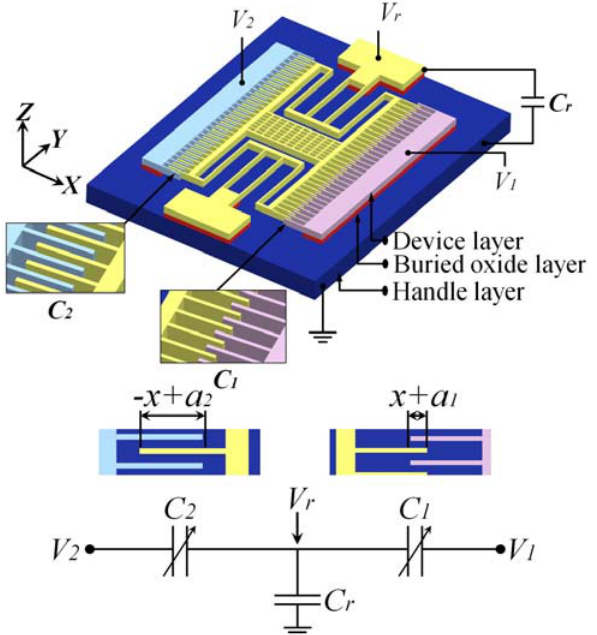
Figure 1. Schematics of the comb-drive actuator with the actuation mechanism of capacitively-coupling-power supply. Different initial overlaps, a initial capacitances, C and C . With the capacitance, C 1 2 and the handle layer, a capacitive circuit is observed. Applying voltages, V the stators and grounding the handle layer, a voltage, V long as V and V are not the same, the rotor will be moved by the net electrostatic force 1 2 generated by the comb